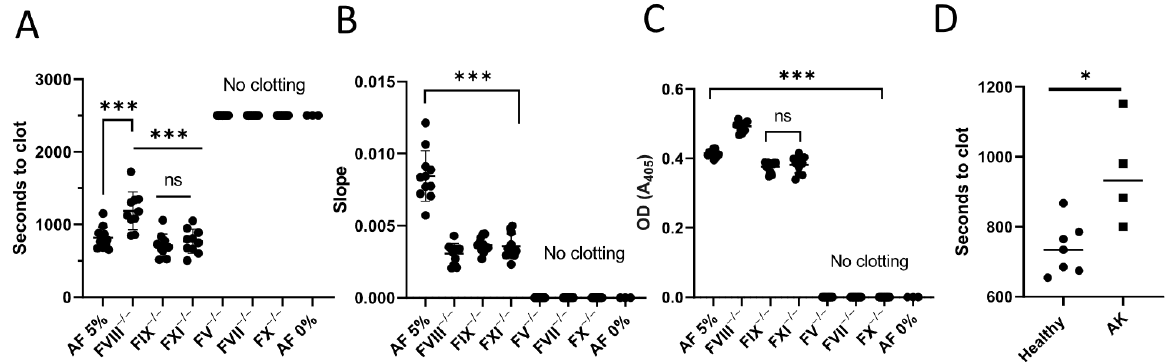
Figure 1. Fibrin generation assay results initiated with AF samples. Clot formation was monitored by turbidity. ( A ) Onset time, ( B ) Curve slope and ( C ) Peak turbidity change for pooled plasma and plasmas deficient in factors VIII, IX, XI, V, VII, X clotted with 5% AF ( n = 11) or pooled control recalcified plasma (AF 0%, n = 3) ( D ) Clotting onset time of samples from groups with healthy and abnormal karyotypes. (Healthy n = 7, AK n = 4). Symbols represent individual AF samples, lines show mean and SD. * p < 0.05, *** p < 0.0005, ns = not significant; AK = abnormal karyotype.